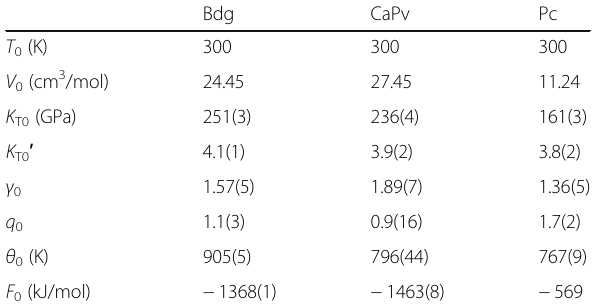
Table 4 Thermodynamic properties of